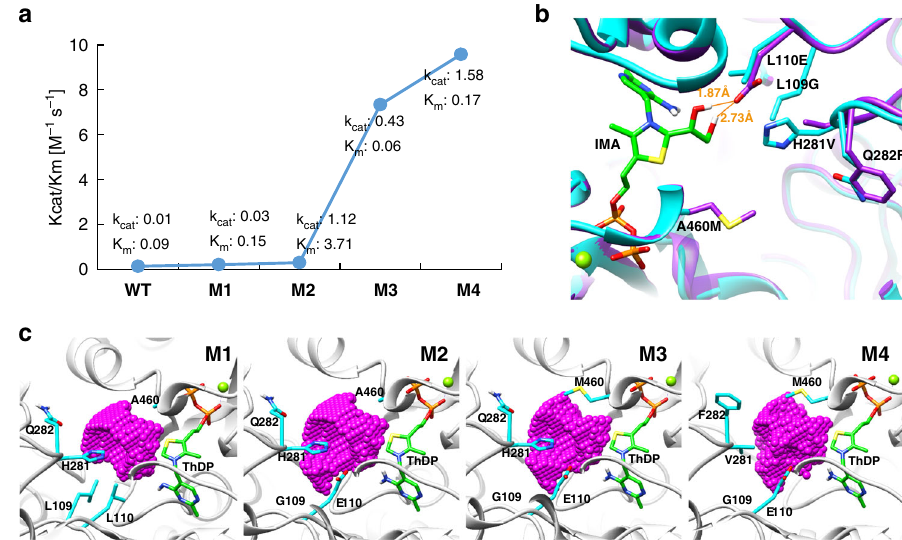
Fig. 3 Protein engineering and mechanism analysis of the glycolaldehyde synthase. a Kinetic parameters of WT and mutants. WT: wild type; M1: mutations at W86R and N87T; M2: mutations at W86R, N87T, L109G, and L110E; M3: mutations at W86R, N87T, L109G, L110E and A460M; M4: mutations at W86R, N87T, L109G, L110E, A460M, H281V, and Q282F. b The overview of the selected fi ve mutations in active center. IMA: intermediate analogue; the orange lines indicate the hydrogen bonds between the hydroxyl group of IMA and the mutation L110E. c The pocket volumes of M1, M2, M3, and M4. Pink dots represent the volumes of the binding-pockets (Supplementary Data 2), which are 131.25, 161.50, 133.38, and 171.38 Å 3 , respectively. The fi gures